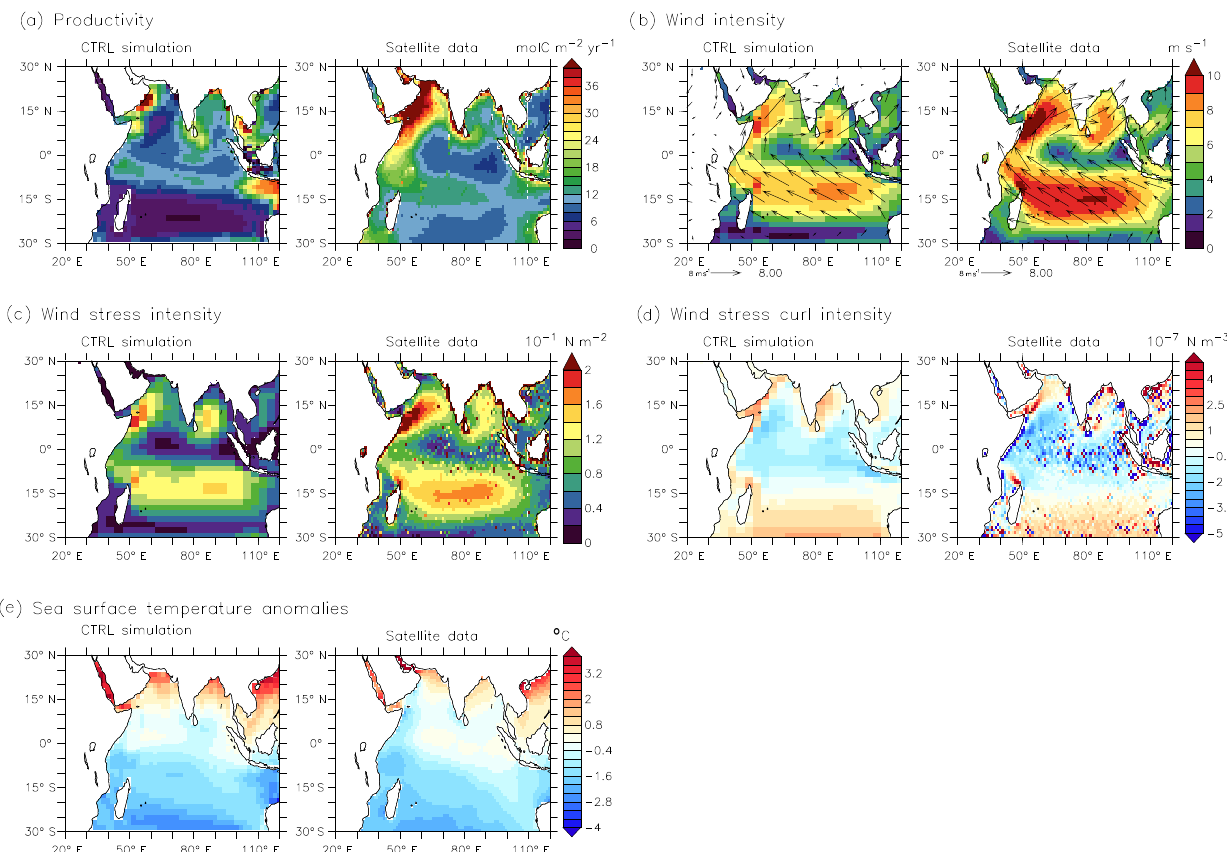
Figure 3. Modelled and observed seasonal (JJAS) patterns of (a) productivity (molCm − 2 yr − 1 ), (b) surface wind intensity (ms − 1 ), (c) sur- face wind stress intensity (10 − 3 Nm − 2 ), (d) surface wind stress curl intensity (10 − 7 Nm − 3 ) and (e) sea surface temperature (SST) ( ◦ C). We used SeaWiFS data in 1998–2005 for productivity (Lévy et al., 2007), multiple-satellite products from NOAA 1995–2005 (Zhang, 2006) for the climatology of surface wind, wind stress and wind stress curl intensity and the ERA-Interim reanalysis 1979–2014 for SST (Dee et al.,